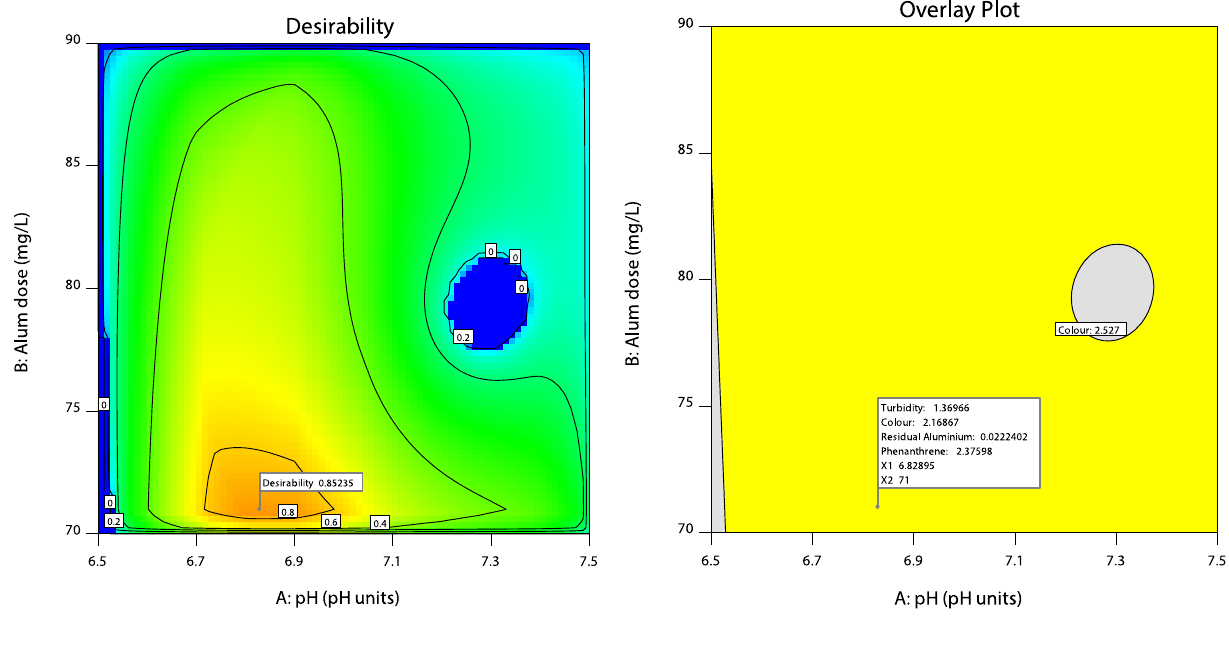
Fig. 4 Desirability and overlay plot for optimum conditions